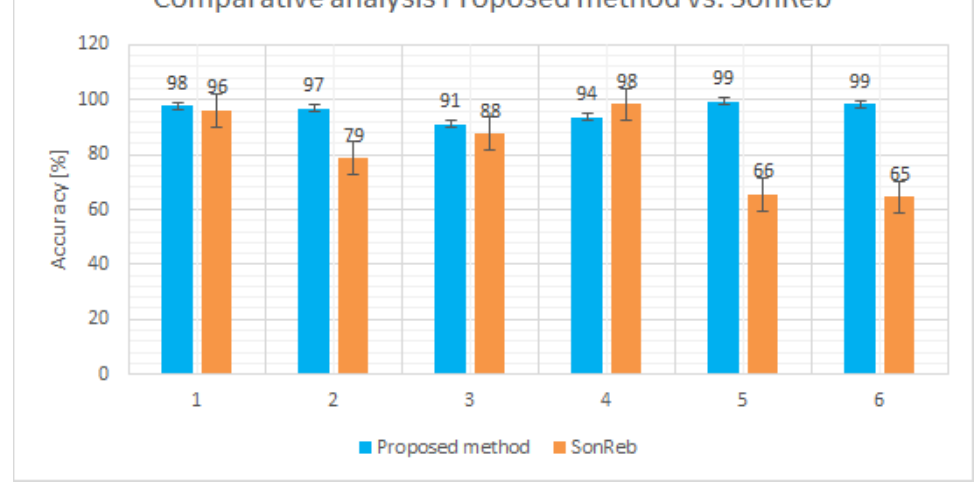
Figure 9. Graphical representation of the accuracy evaluation of each method, proposed and SonReb method, with respect to the reference method (destructive